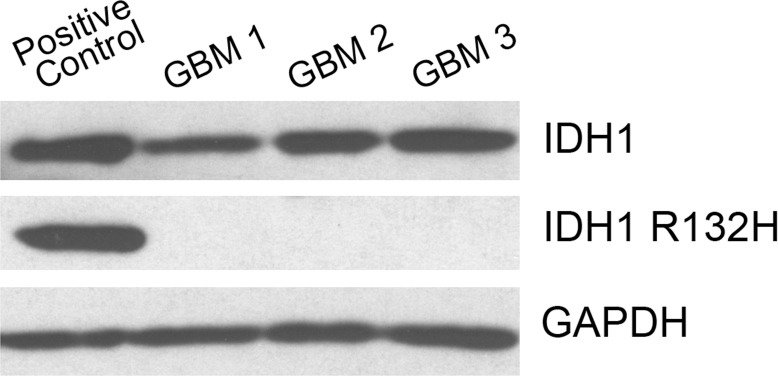
IDH1 mutation status of human GBM samples.Three frozen GBM specimens used for previous analysis and known to express CD97 were found to express wild-type IDH1, but not mutant IDH1 (R132H) by Western blot.